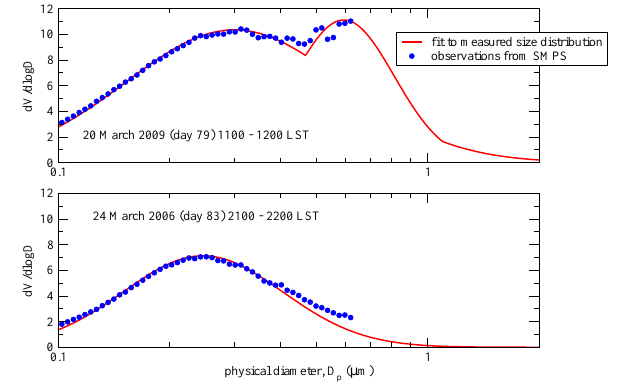
Fig. 3. The blue dots represent the measured size distribution, as measured by the SMPS. The size distribution is an hourly average. The red curves show fits to these